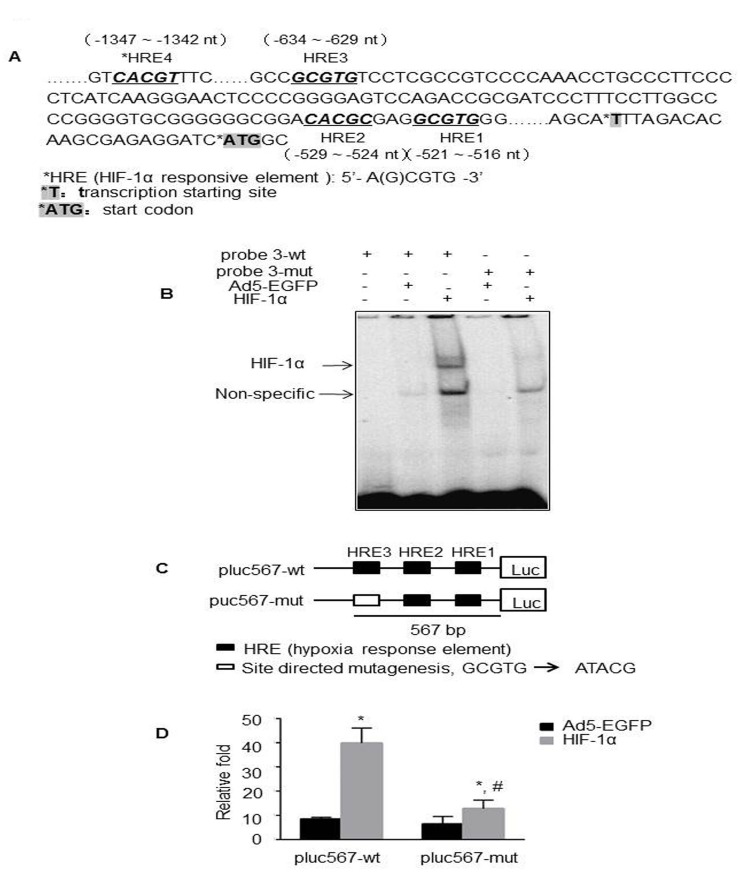
Regulation of ZEB1 by HIF-1α through HRE-3.(A) Schematic representation of the proximal promoter (~ 3500 nt upstream) of ZEB1 gene. HRE: hypoxia response element. (B) Oligonucleotides for EMSA were wildtype (lane 1–3) and mutant (lane 4–5) probe 3 from the ZEB1 promoter, which contained a consensus HRE-3. Nuclear extracts prepared from HT29-Ad5-HIF-1α (lane 3 and 5) or control cells (lane 2 and 4) were incubated with [γ-32P] ATP-labelled probe before electrophoresis. Negative control was performed with wildtype probe without nuclear extract (lane 1). (C) Schematic representation of the promoter region of ZEB1 and the report constructs used in adenovirus-infected experiments. The constructs contained wildtype (pluc567-wt) or mutant (pluc567-mut) HRE-3 located -634 ~ -630 nt upstream of the transcription start site of ZEB1. (D) Activation of plu567 or pluc567-mut in Ad5-HIF-1α- or Ad5-EGFP-infected HT29 cells (N = 3 replicate experiments). *, #
P < 0.05.